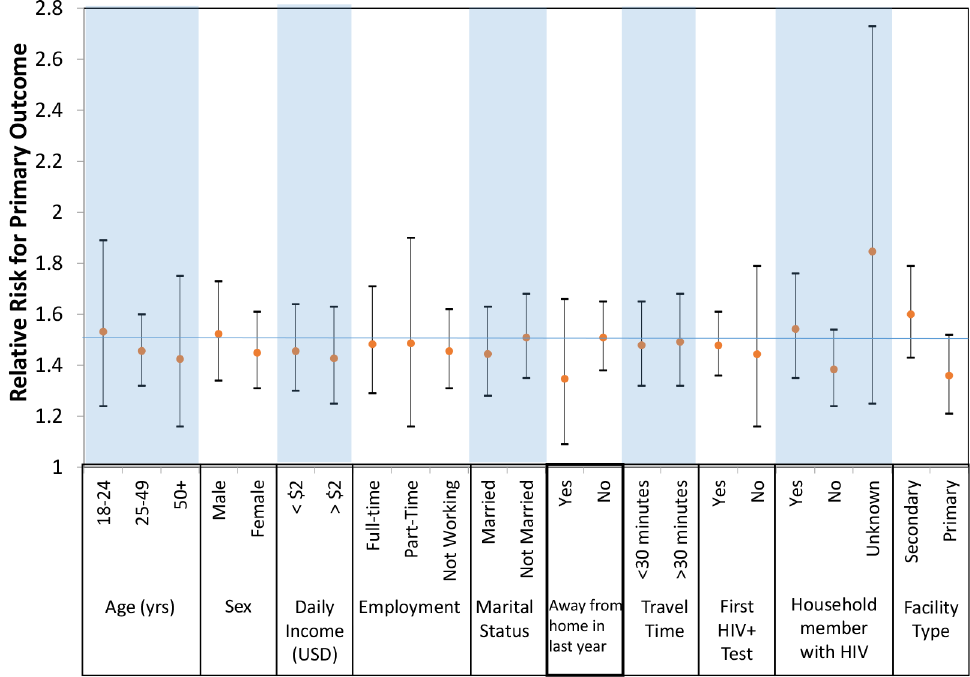
Fig 4. Primary outcome by subgroups of participants. USD, US dollars; yrs,